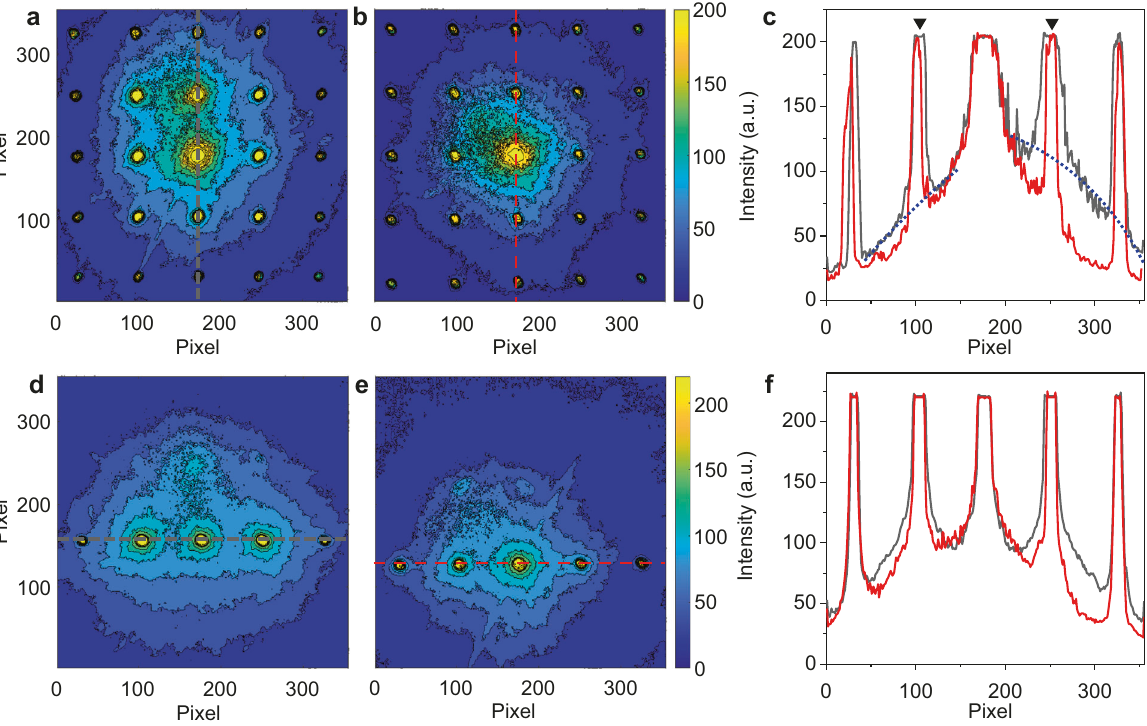
Fig. 4 The analysis of scatter performance of the planar grating. a , b Derived diffraction intensity of relief grating coated photoresist and planar grating from Fig. 3l, n, respectively. c Plotting the data along the dashed lines in a and b correspondingly. The red curve showing lower scattering (blue dots) and narrower width of peaks (inverted triangles) compared with the gray curve. d – f Same analysis applied on Fig. 3k,